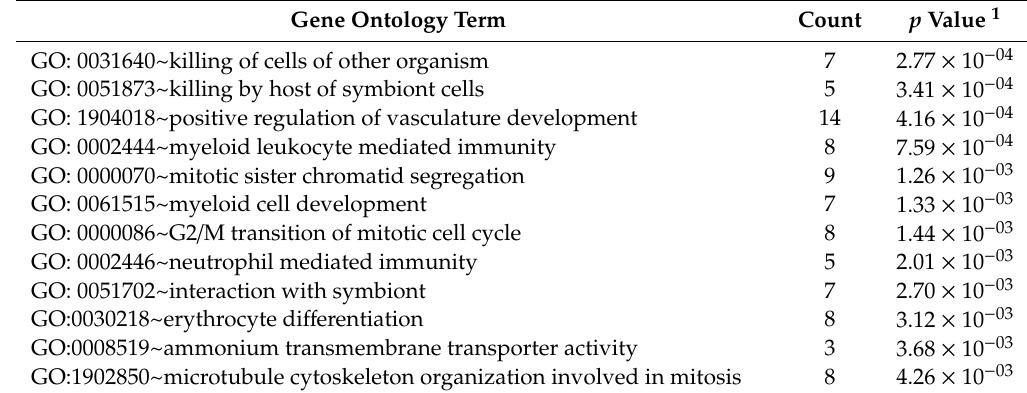
Table 2. The Gene ontology enrichment analysis of splenic